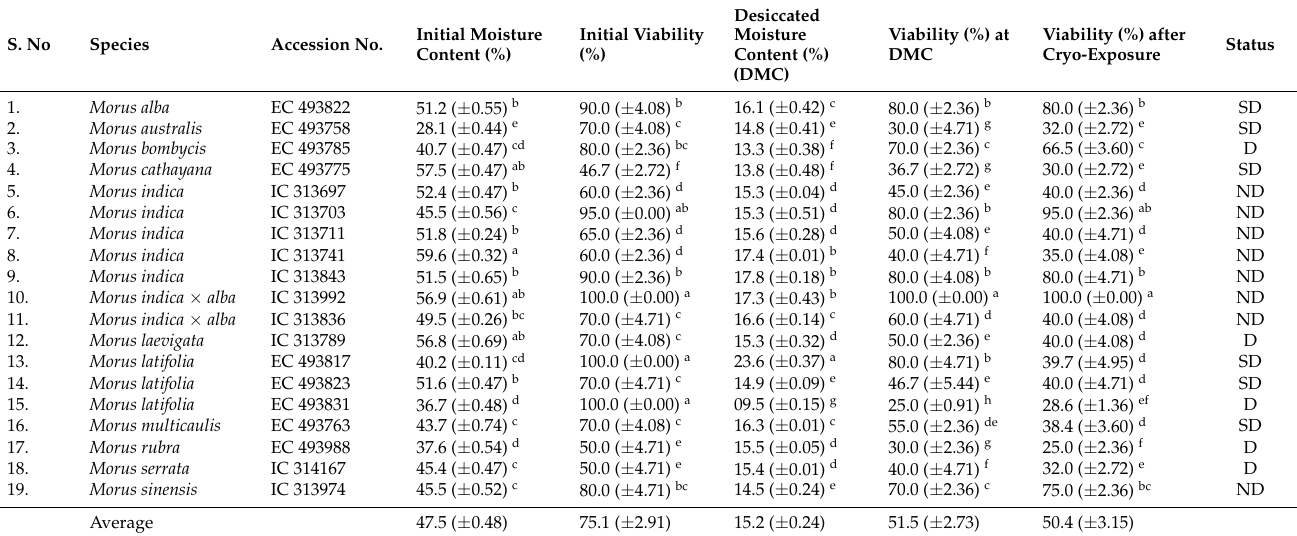
Table 1. Viability and dormancy status of dormant buds of different Morus